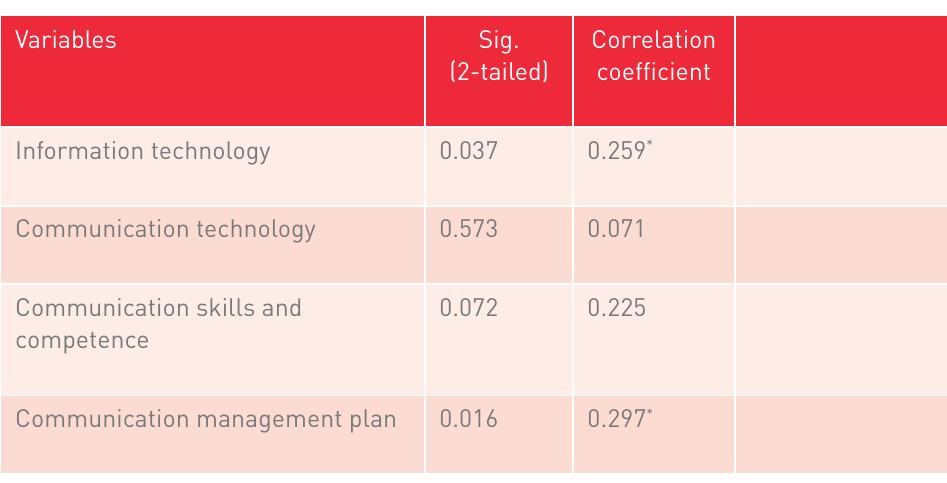
Correlation between communication management practices and project